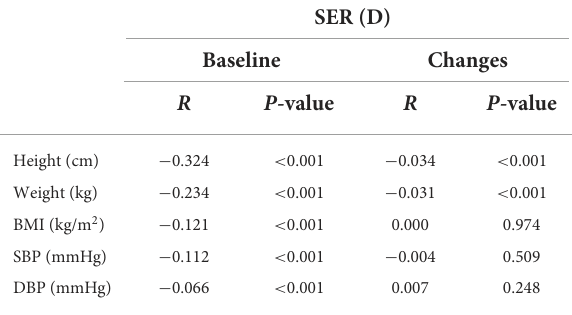
TABLE 2 Bivariate correlations of SER with height, weight, BMI, SBP, and